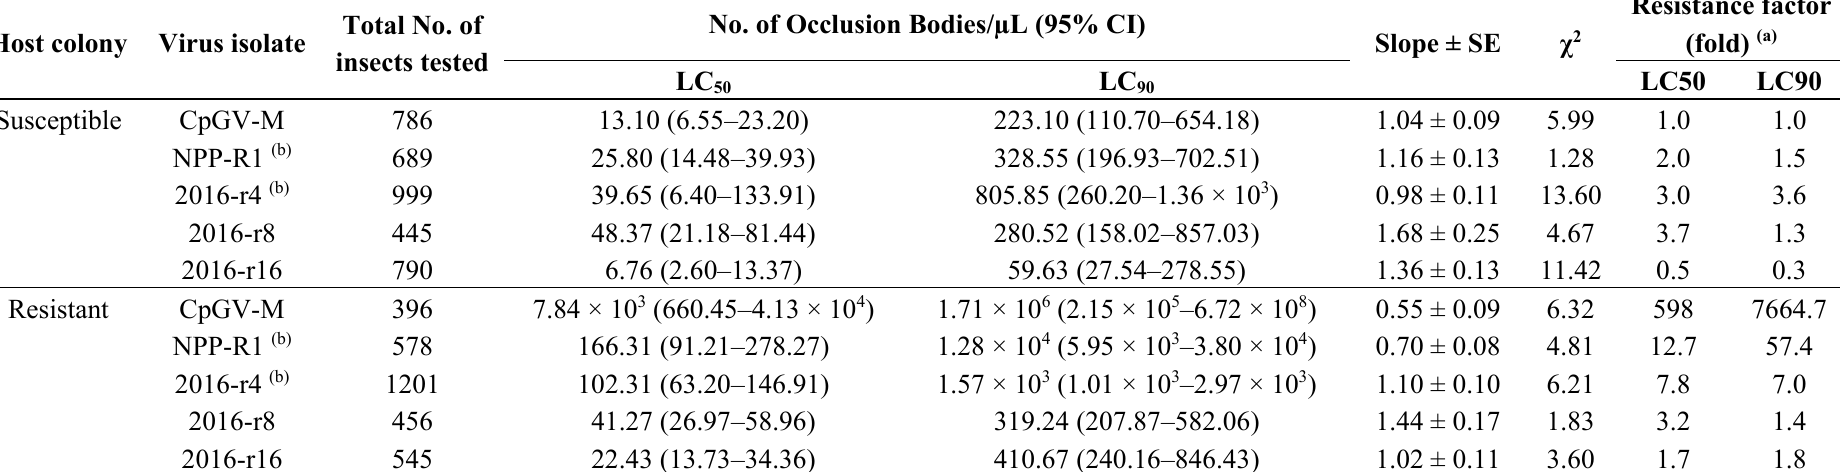
Table 2. Pathogenicities, measured by LC 50 and LC 90 , of four virus isolates on Cydia pomonella laboratory colonies susceptible and resistant to